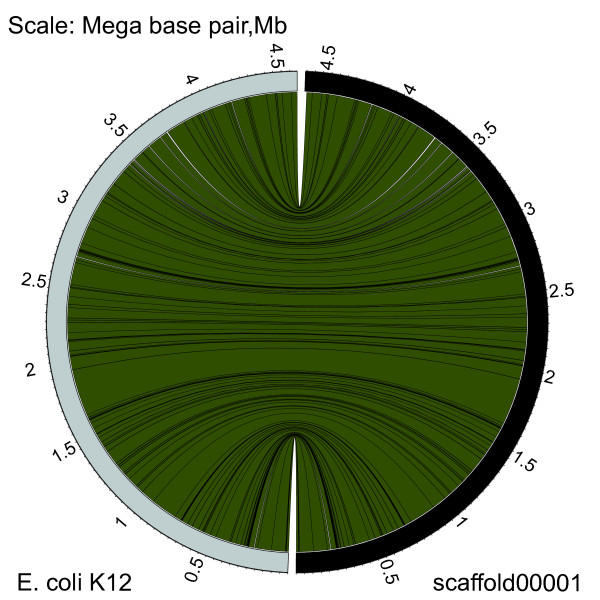
Alignment results of the full-length genomic sequence of the E. coli K12 strain and the first scaffold from its assembly result by 10×SE + 10×PE sequencing strategy (real data). E. coli K12 sequence is on the left side and the sequence of the first scaffold is on the right side. Ribbons represent the alignment blocks extracted from the MUMmer result.